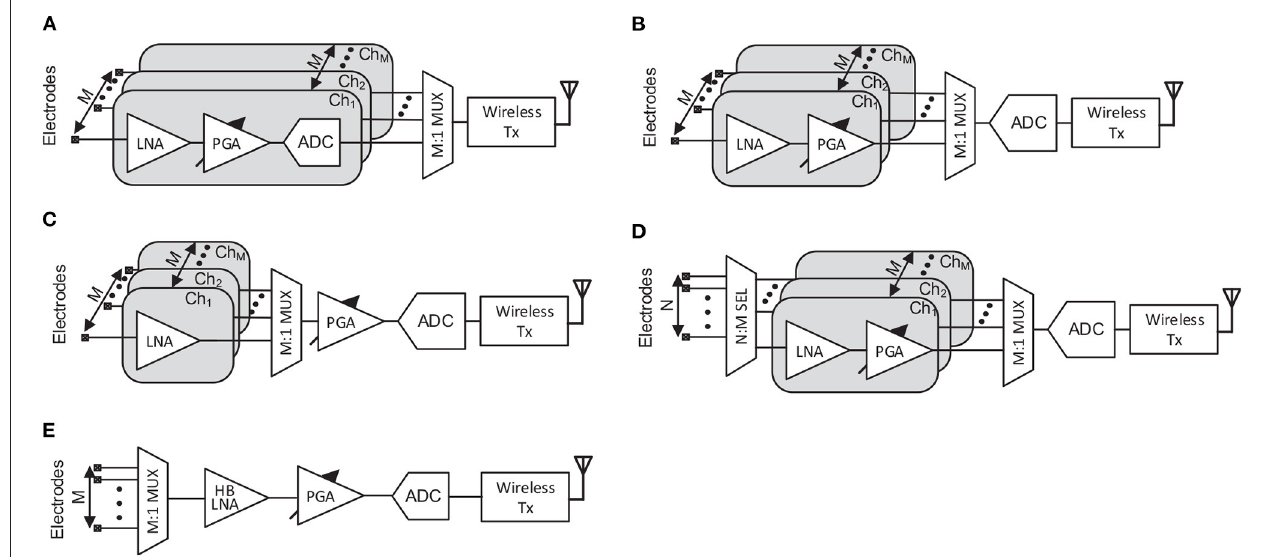
FIGURE 8 | Taxonomy of different AFEs depending on the location of the multiplexer. (A) Non-multiplexed AFE topology. (B) ADC sharing AFE topology. (C) PGA sharing AFE topology. (D) Switch array AFE topology. (E) Time-division-multiplexing AFE